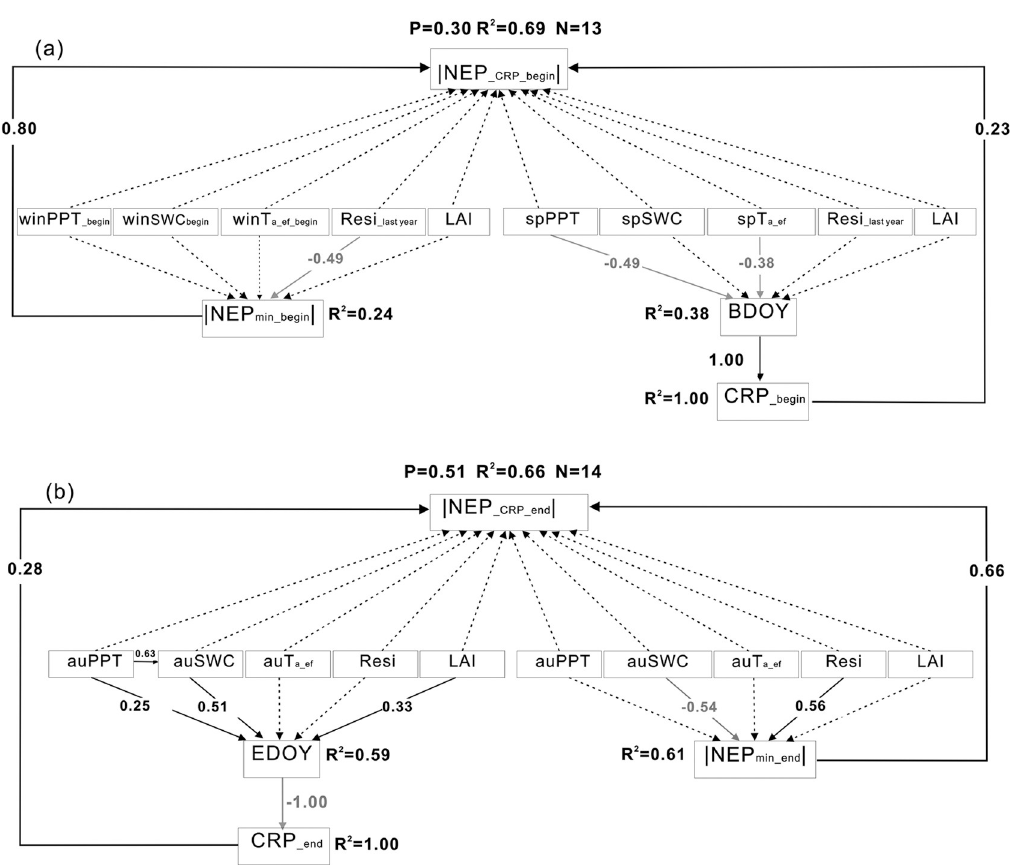
Fig 5. Results of the structural equation modeling of the relationships among annual anomalies of climatic and biotic variables, carbon dioxide release periods (CRP), minimum daily net ecosystem production (NEP min ) and net ecosystem production (NEP) during the release period, (a) at the beginning of the year, and (b) at the end of the year. Black arrows indicate significant positive relationships, while gray arrows indicate significant negative relationships (P < 0.05). Black dashed arrows indicate insignificant relationships (P > 0.05). Numbers adjacent to arrows are path coefficients indicating the effect size of the relationship. The proportion of variance explained is given by R 2 . sp, au, and win indicate spring, autumn, and winter, respectively. Resi _last year indicates the amount of harvest residues remaining on the ground the previous year; Resi indicates the amount of residues in current